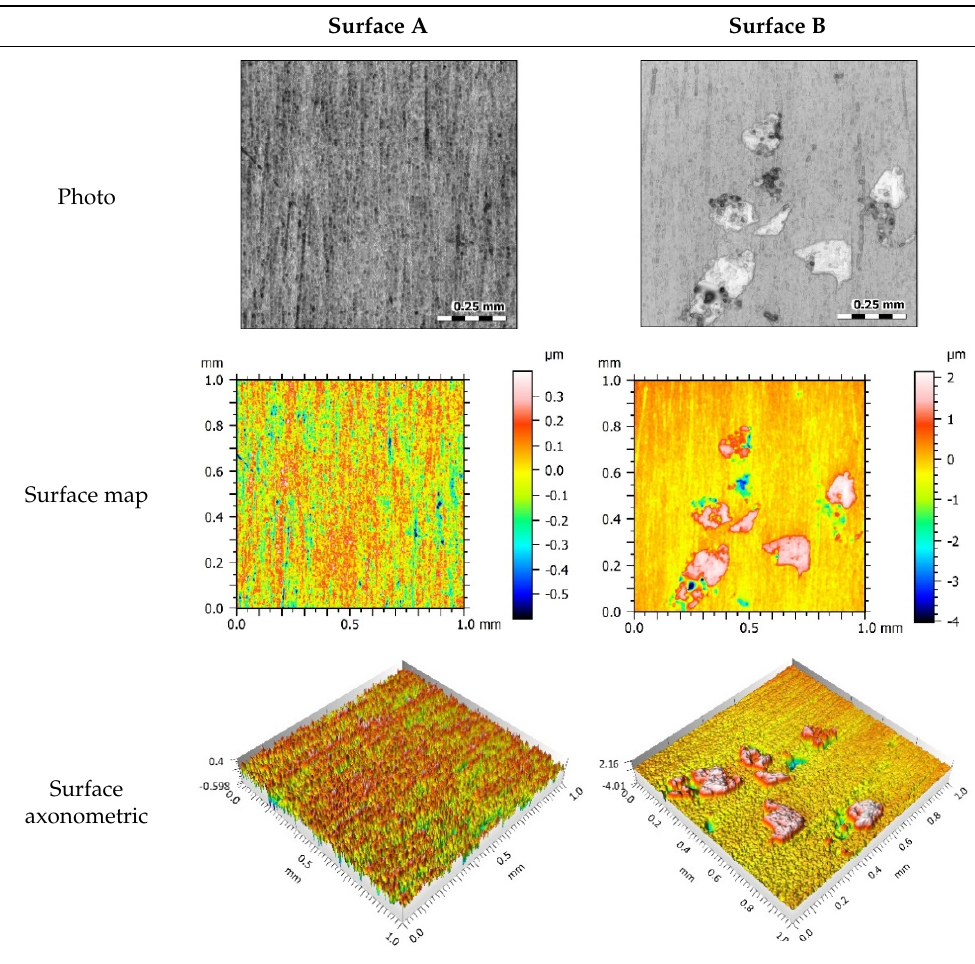
Table 3. Results of manufactured surface topography.